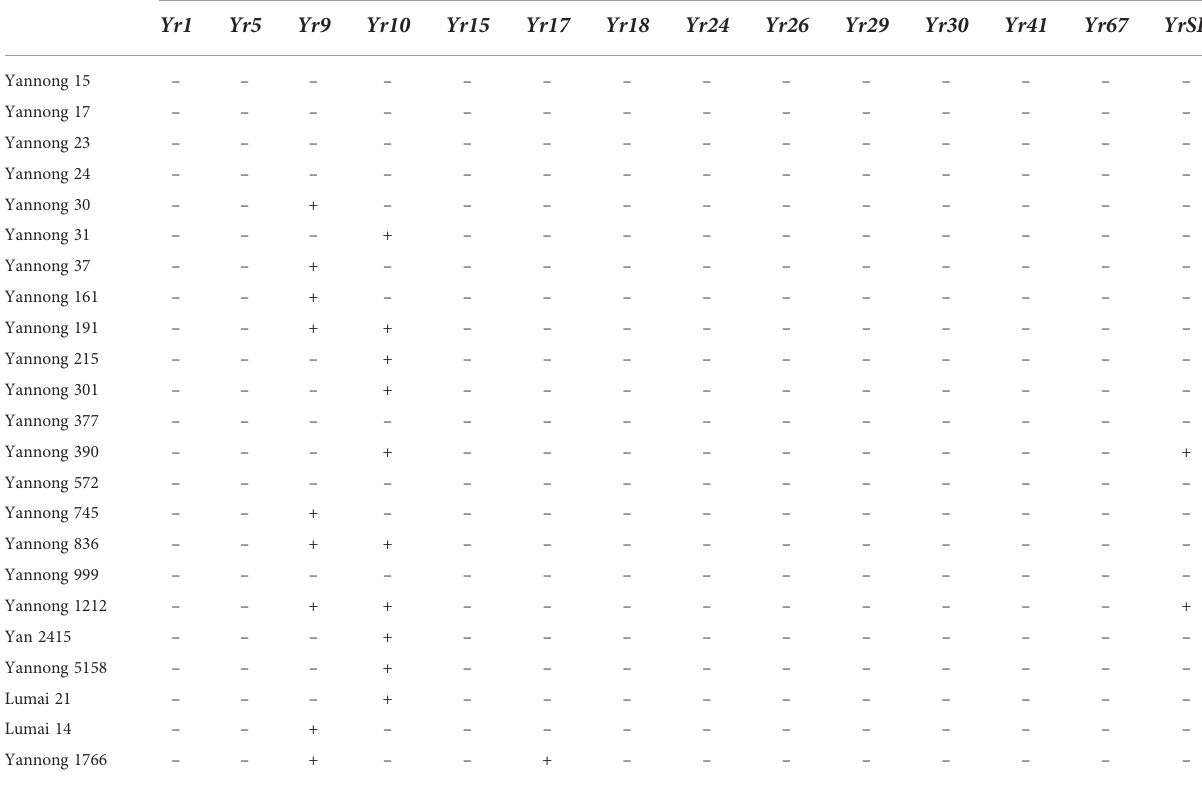
TABLE 4 Detection of stripe rust ( Yr ) resistance genes in 23 Yannong cultivars/lines. Cultivar/line Stripe rust ( Yr ) resistance